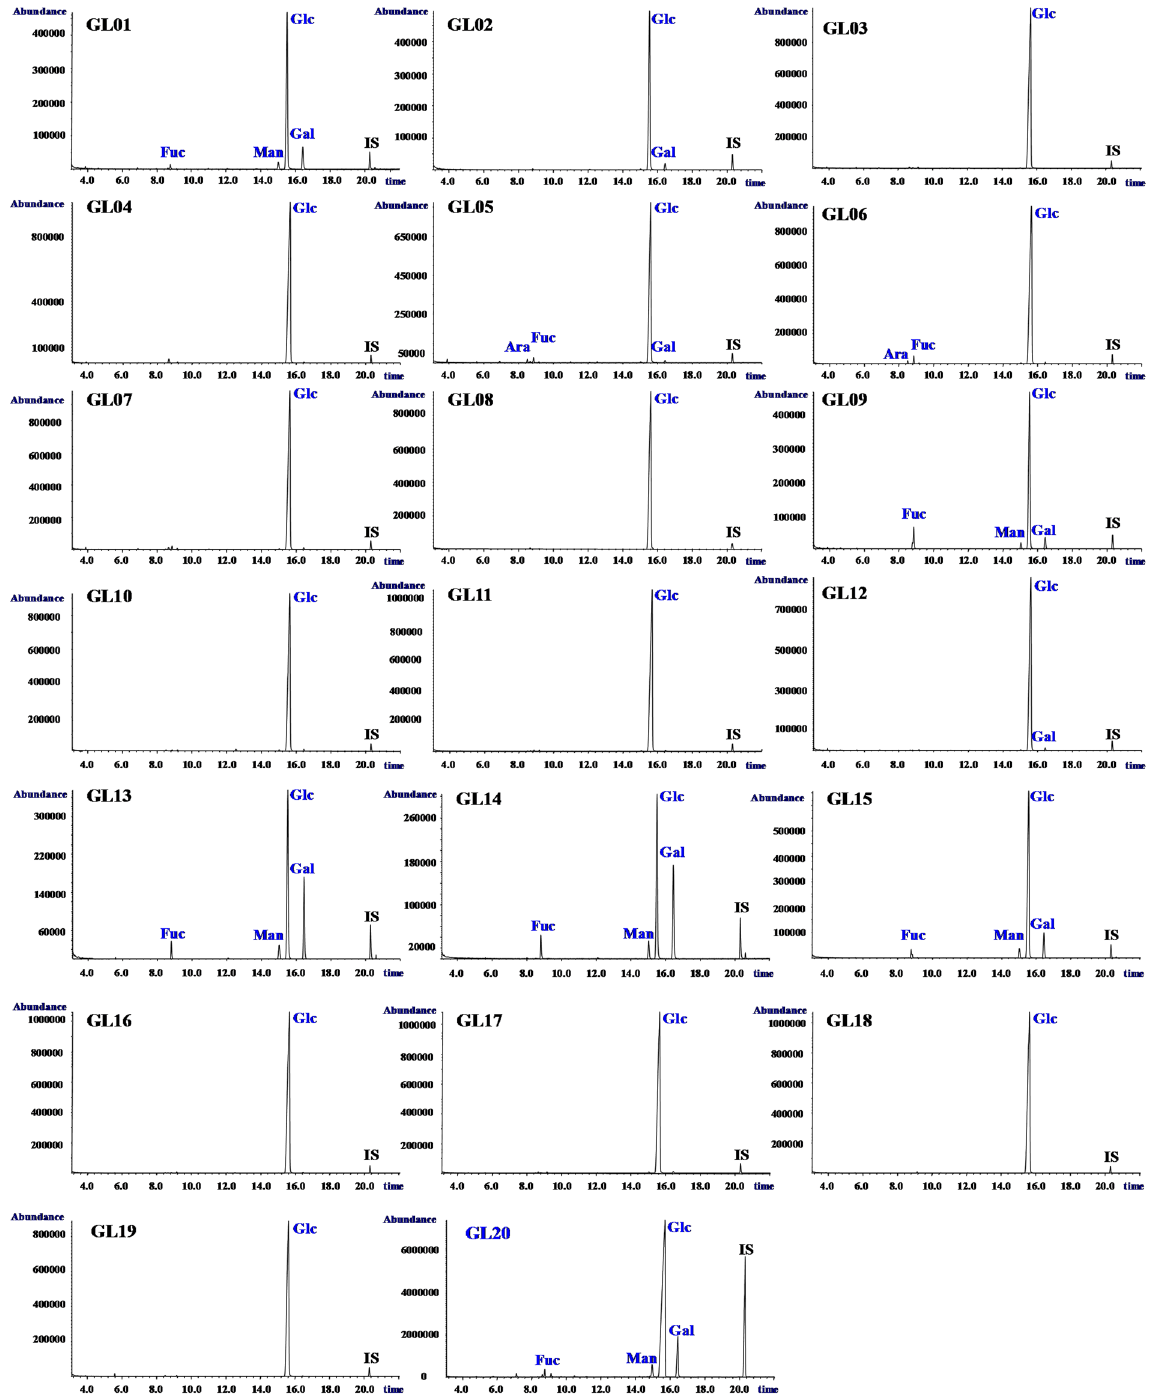
Figure 5. GC-MS profiles of methylated hydrolysates of polysaccharides from G . lucidum dietary supplements. Ara , arabinose; Fuc , fucose; Man , mannose; Glc , Glucose; Gal , Galactose; IS , internal standard. Sample codes were the same as in Table